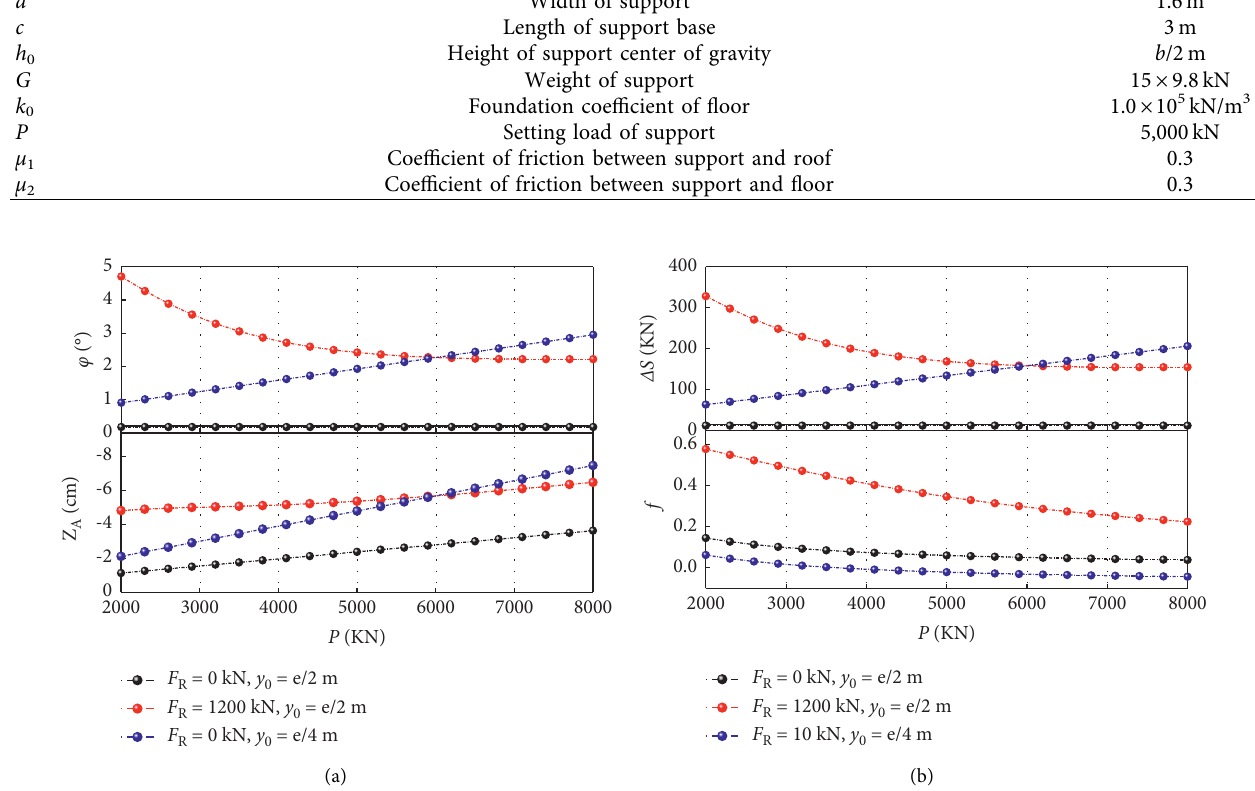
Figure 11: Influence of working resistance on support stability ( h � 4 m). (a) Influence of working resistance on support rotation. (b) Influence of working resistance on support sliding.